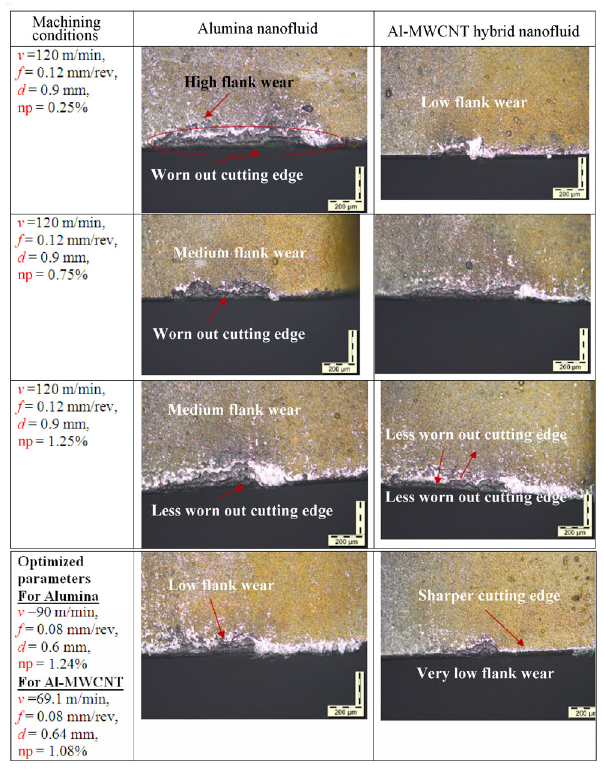
Fig. 13 Microscopic photographs of tool flank wear with alumina nanofluids and Al-MWCNT hybrid nanofluids at v =120 m/min, f = 0.12 mm/rev, d = 0.9 mm and at optimized process parameters, respectively.